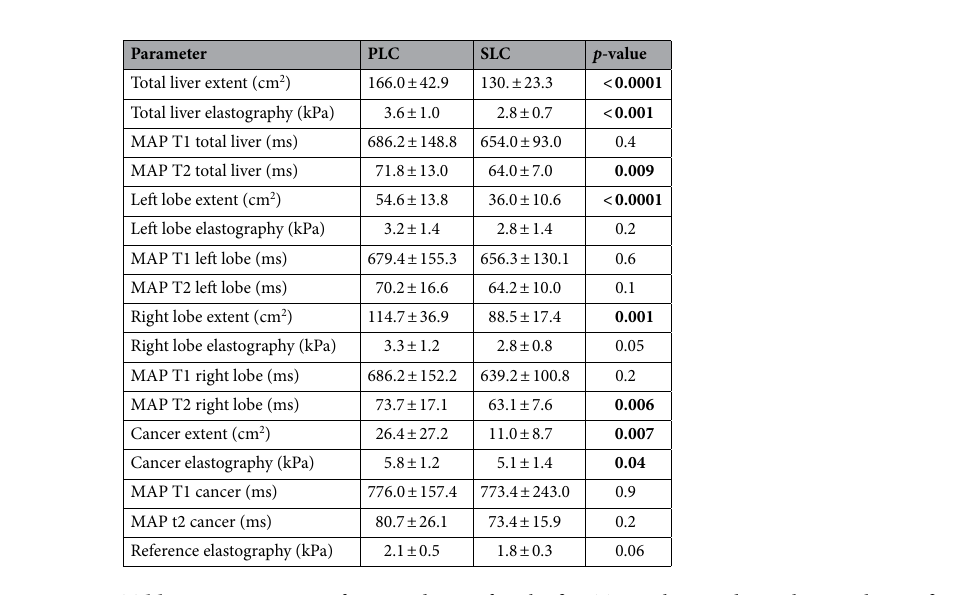
Table 3. Comparison of PLC and SLC after the first TACE therapy. kPa Kilp pascal. Significant values are in bold.